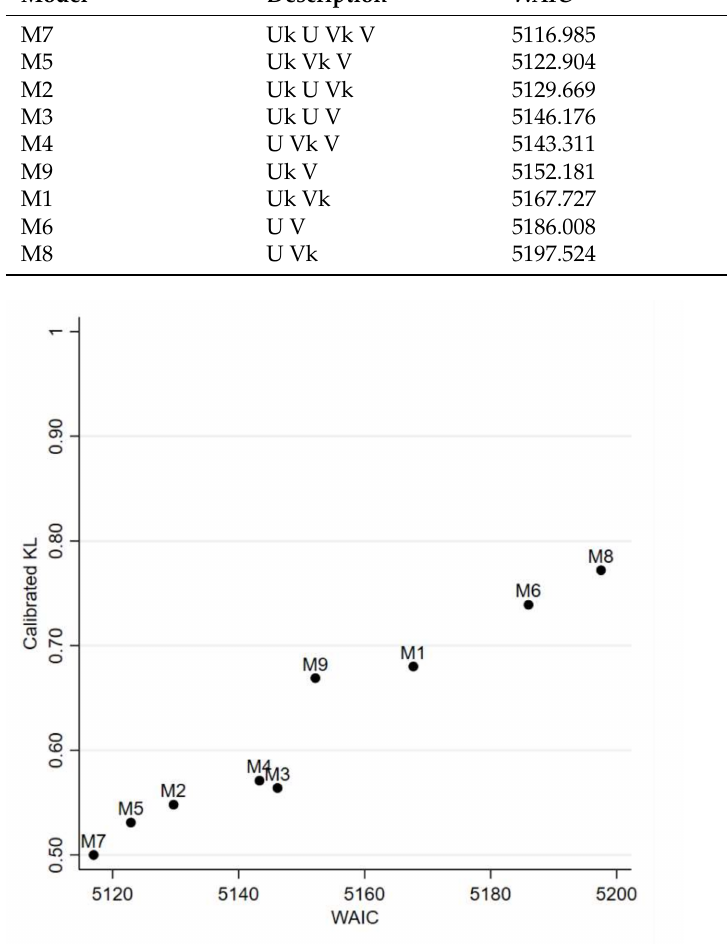
Figure 4. Scatter plot of median calibrated Kullback–Leibler divergence (calibrated KL ) vs. predictive accuracy measured by the widely applicable or Watanabe–Akaike information criterion ( WAIC ) for each fitted Bayesian model. Calibrated KL was calculated with regard to model 7—the more complex and best-supported model. Ovarian cancer and pleural cancer mortality by municipality. Lombardy Region,